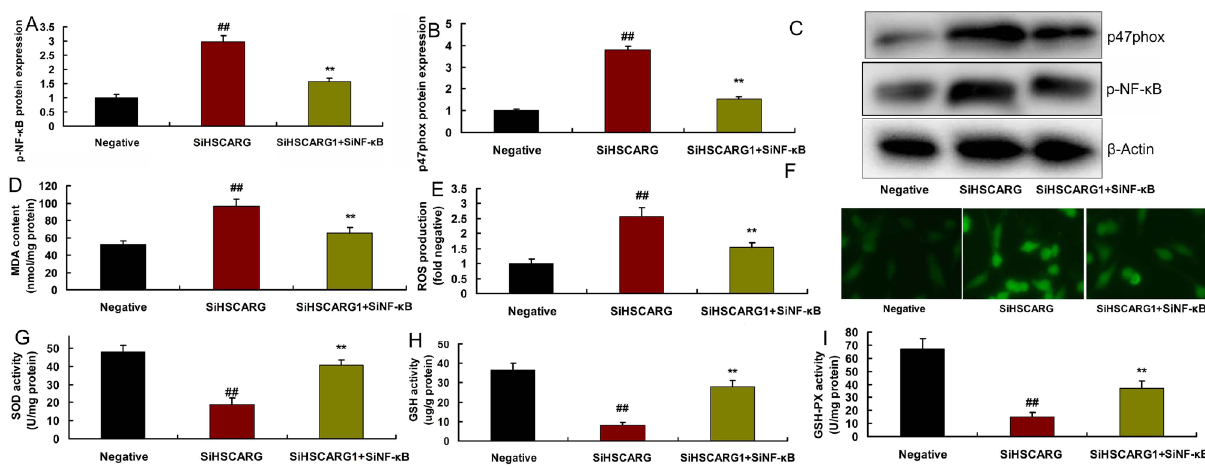
Fig. 7 - Downregulation of nuclear factor kappa B (NF-κB) activity in the effects of HSCARG in coronary heart disease. 47phox/NF-κB protein expressions (A, B, and C), malondialdehyde (MDA) and reactive oxygen species (ROS) production levels (D, E, and F), superoxide dismutase (SOD), glutathione (GSH), and glutathione peroxidase (GSH-PX) levels (G, H, and I). Negative=negative mimic group; SiHSCARG=downregulation of HSCARG group; SiHSCARG+siNF-κB=downregulation of HSCARG and NF-κB group. ##P<0.01 compared with negative mimic group; **P<0.01 compared with downregulation of HSCARG group